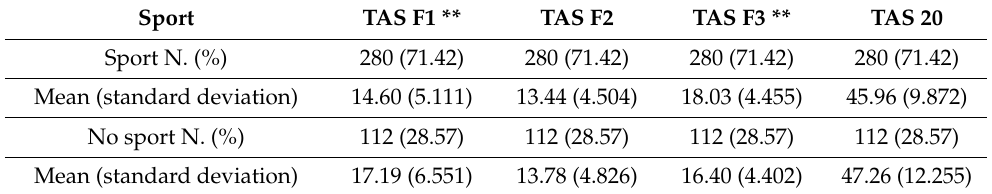
Table 2. Summary of cases Sport/TAS